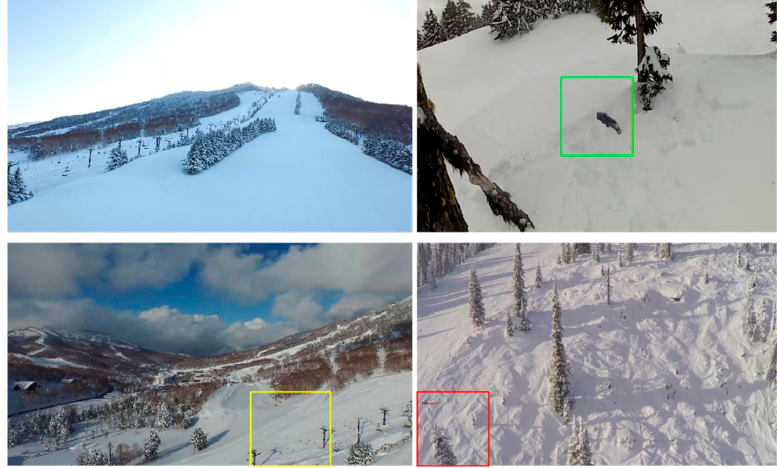
Figure 7. Example of correctly classified negative ( top left ) and positive ( top right ), false positive object marked in yellow rectangle ( bottom left ), and false negative object marked by red rectangle ( bottom right ). Table 3. Classification results for the first dataset (Experiments 1–3).